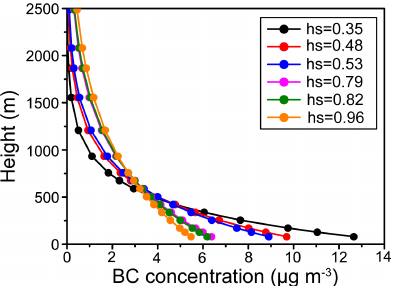
Figure 11. Vertical profiles of BC concentrations parameterized as six exponential functions for 12 and 16–19 December